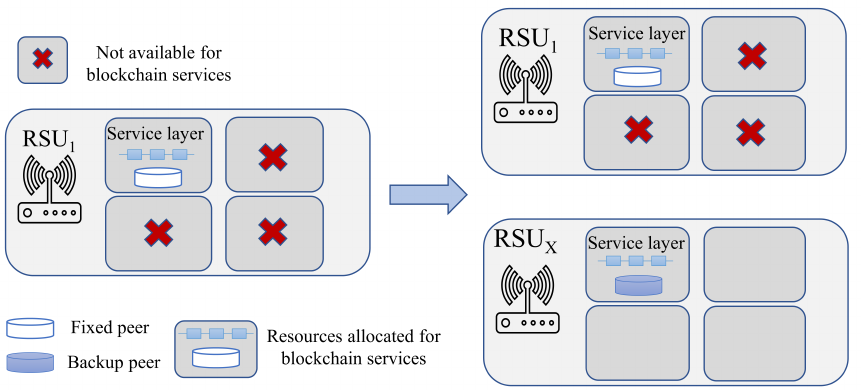
Figure 5. Scaling up with backup peer in the network with the proposed scaling control